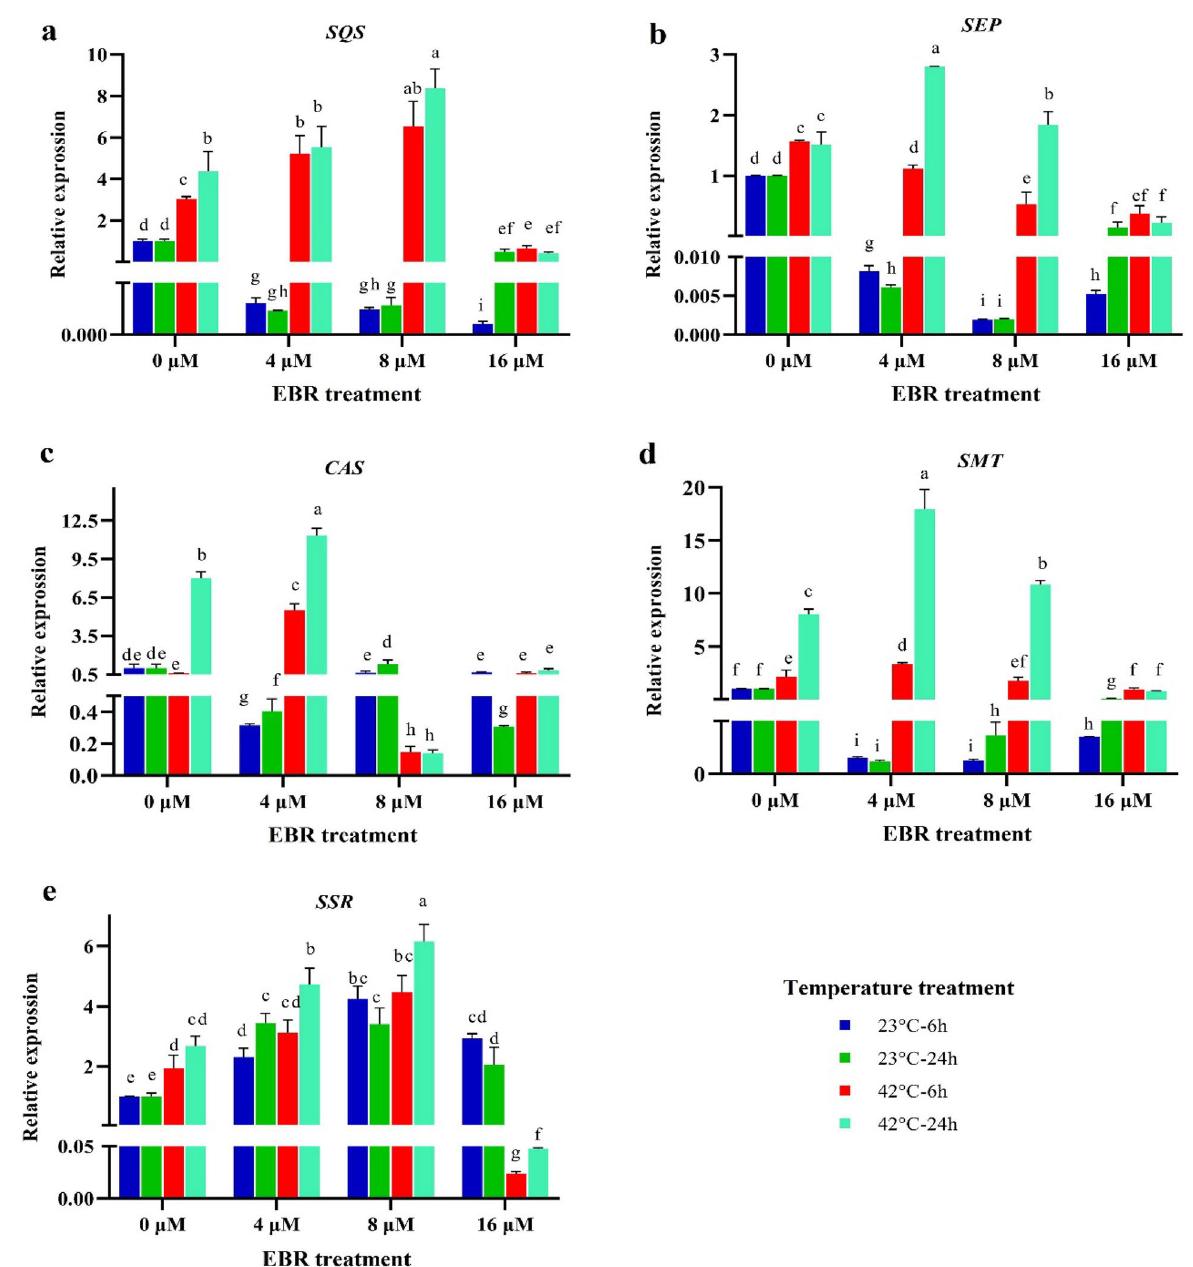
Figure 6. The effects of temperature, harvesting times, and different levels of EBR on the expression levels of SQS ( a ) , SEP ( b ) , CAS ( c ), SMT ( d ), and SSR ( e ). Duncan method at a 1% probability level was applied to compare mean values. The columns having similar letters had no significant